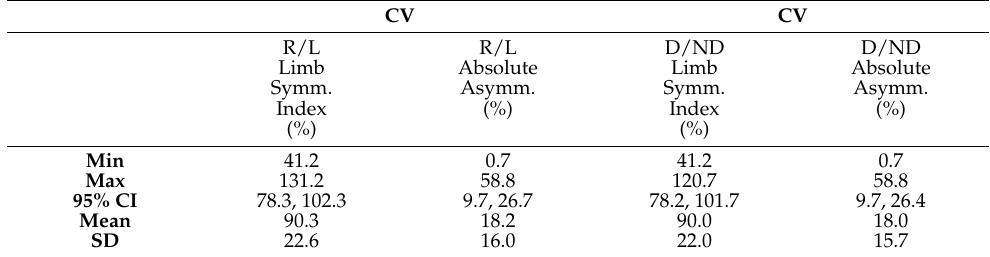
Table 4. Summary statistics for the coefficient of variation limb symmetry indices and absolute asymmetries (n = 16).